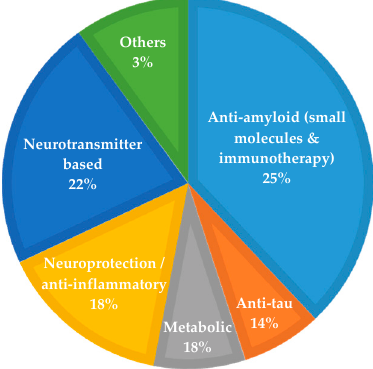
Figure 1. Mechanism of action of AD agents in clinical trials in 2018. Adapted from [14].